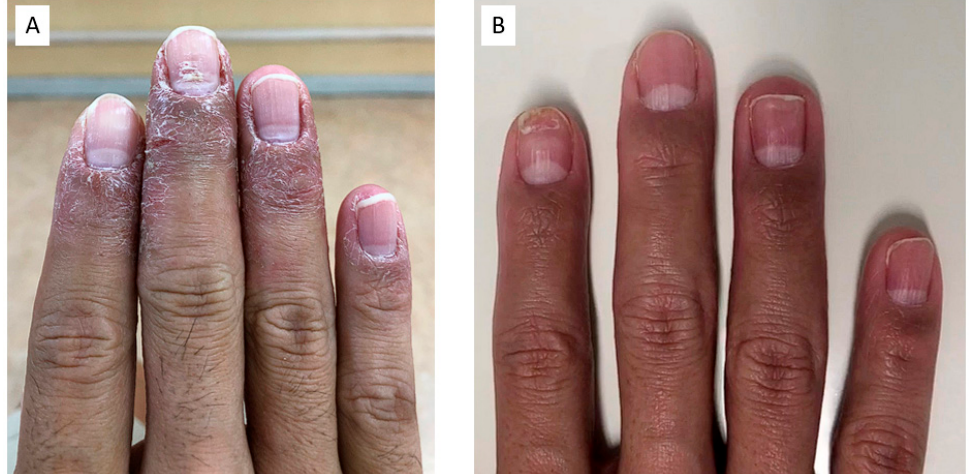
Figure 5. Skin manifestations of the right fingers: ( A ) preoperative finding; ( B ) postoperative finding.